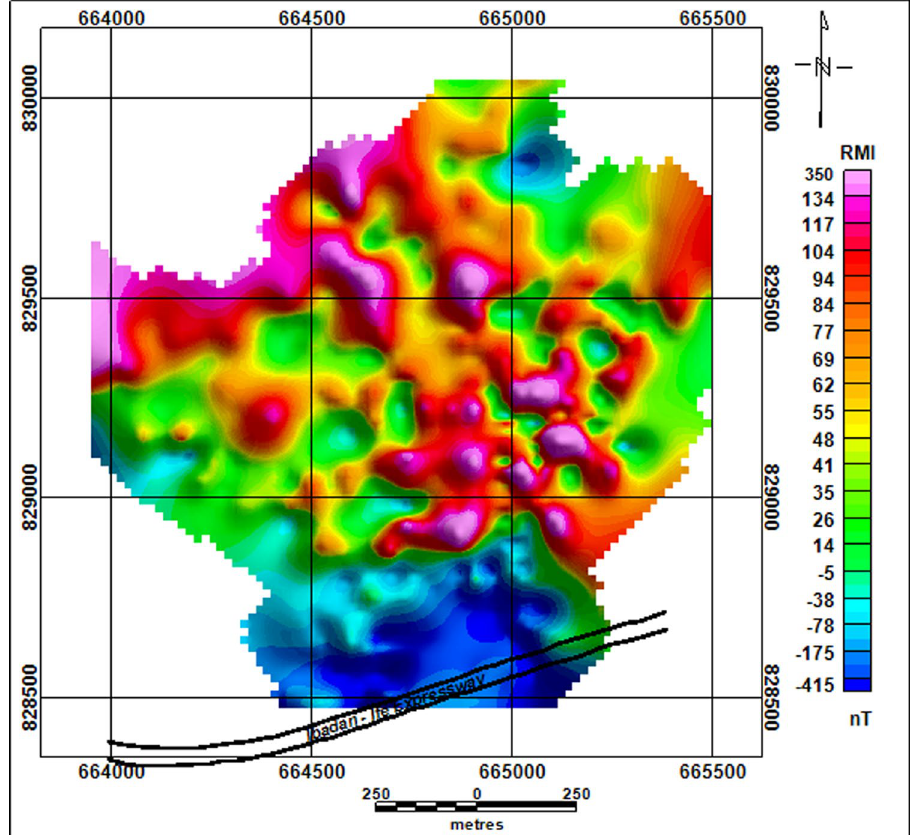
Fig. 4 Residual magnetic intensity (RMI) map of the study